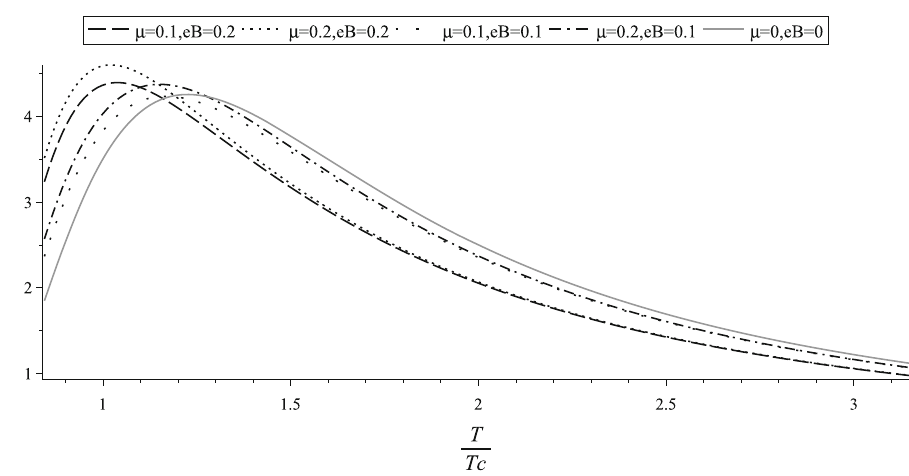
Fig. 3 The combination (cid:7) for QGP with u, d, s quark flavors as a function of T at various values of μ B [ GeV ] and eB [ GeV 2